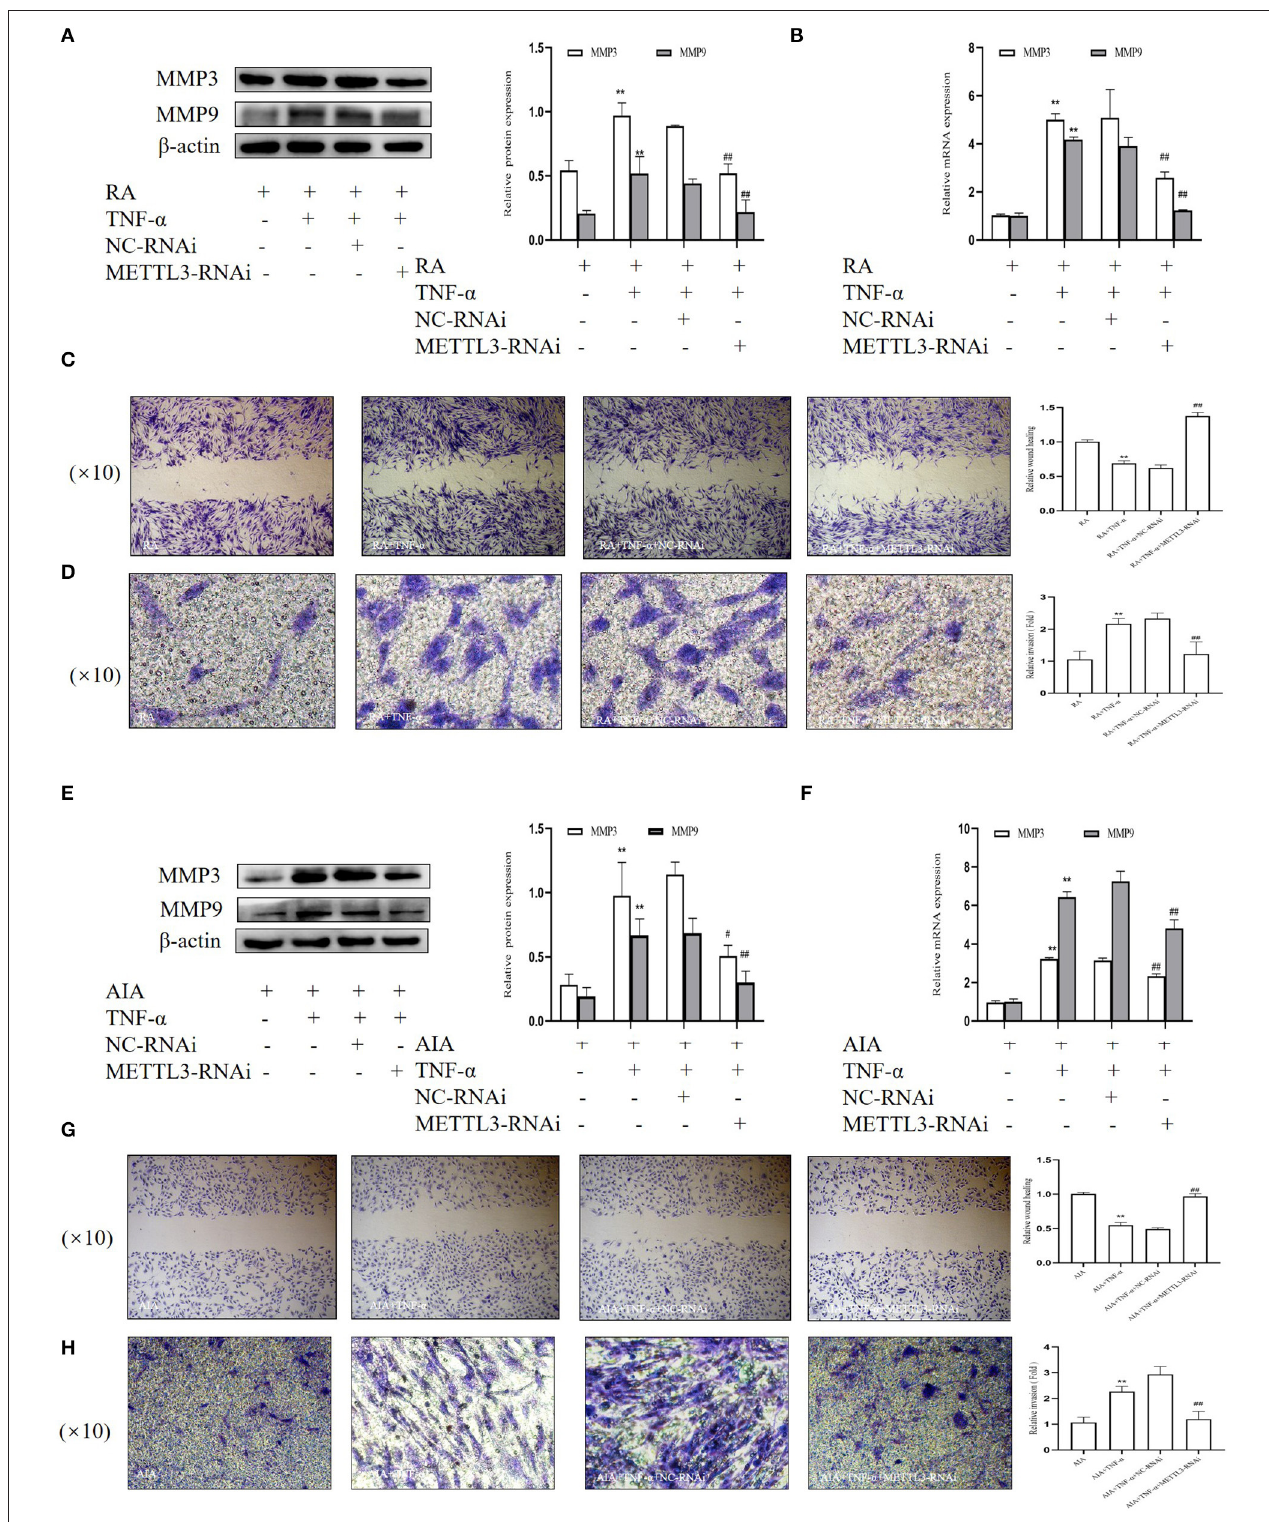
FIGURE 7 | Methyltransferase-like 3 (METTL3)-RNAi inhibits migration and invasion in fibroblast-like synoviocytes (FLSs). (A) Western blotting was used to measure MMP3 and MMP9 protein levels after METTL3 silencing in rheumatoid arthritis (RA)-FLSs. (B) MMP3 and MMP9 mRNA levels were detected by real-time